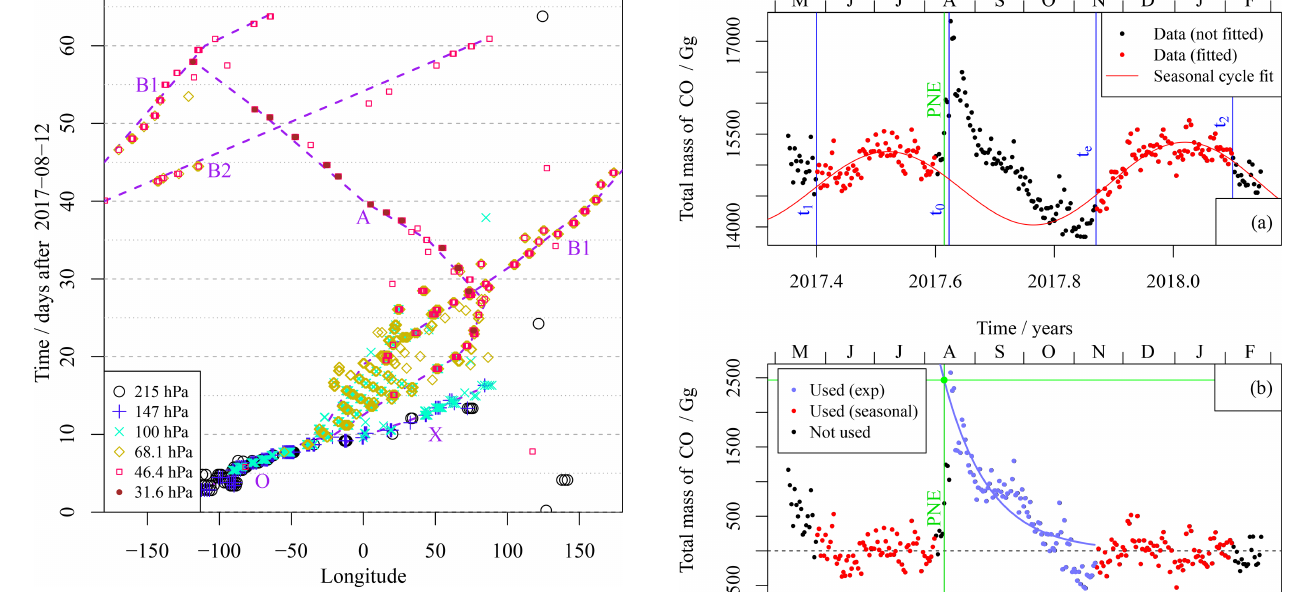
Figure 4. Longitudes of enhanced CO (as defined in the text), plot- ted as a function of time. Colours and symbols represent pressure. Dashed lines and labels identify the various parts into which the polluted air mass is observed to divide.